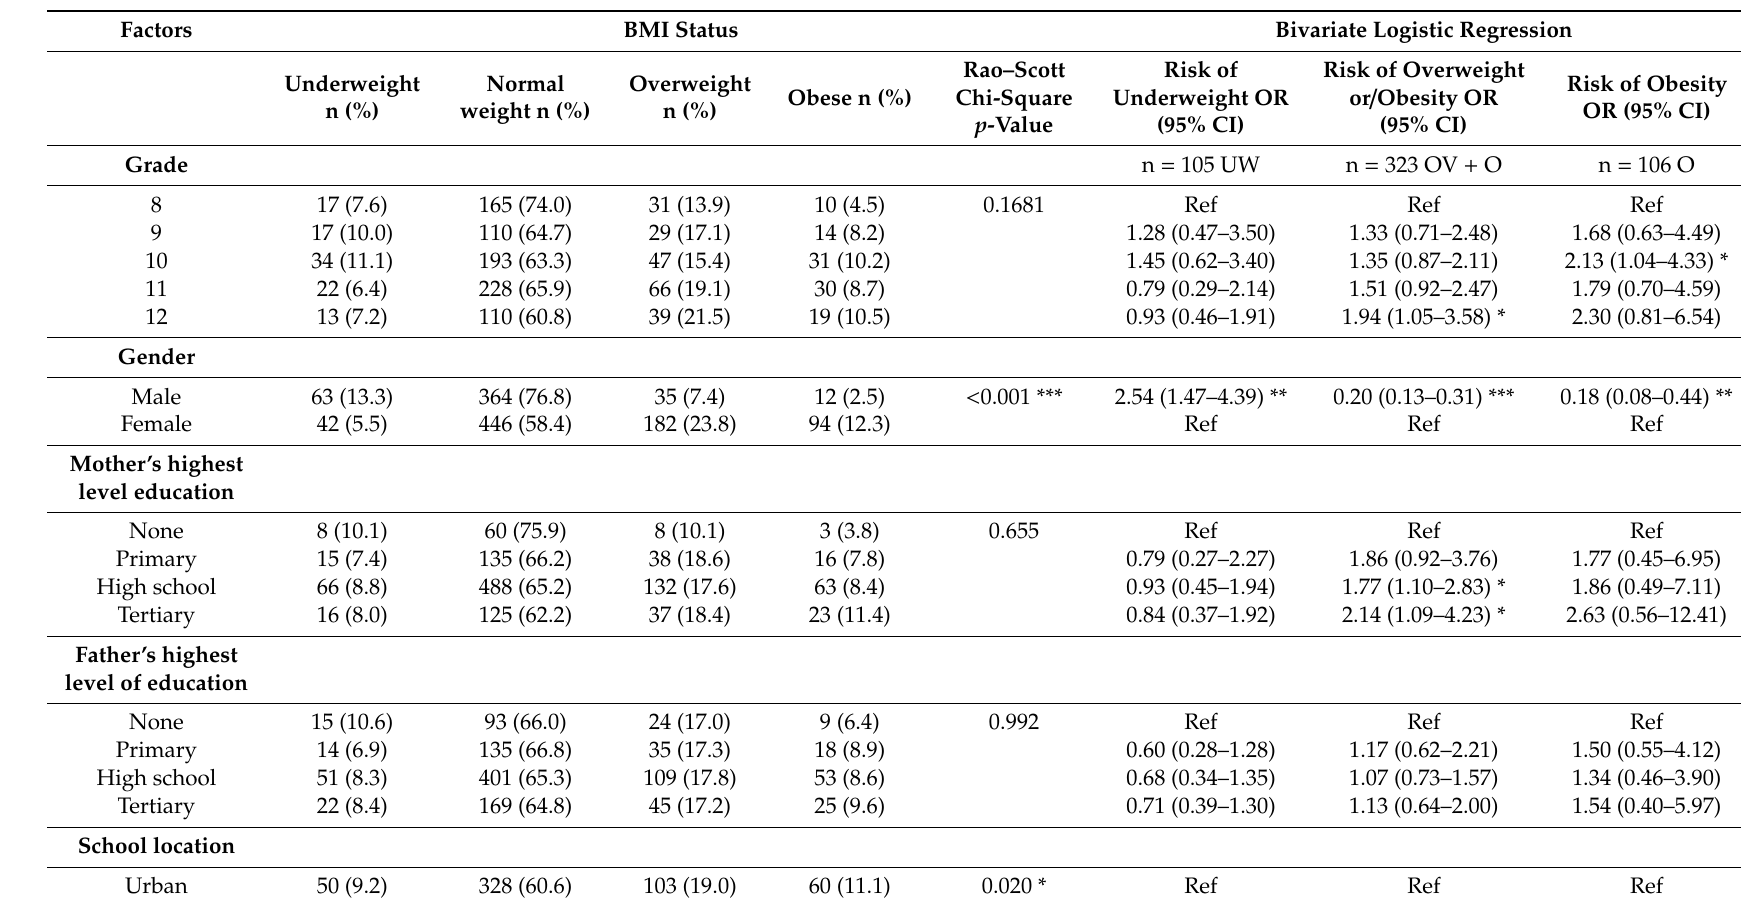
Table 5. Socio-demographic factors associated with nutritional status using BMI as an indicator and bivariate logistic regression with BMI status as outcome.